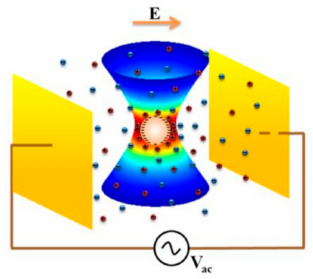
Figure 6. Schematic illustration of a charged colloidal particle held by an optical tweezer (with a harmonic potential) and driven by an oscillating electric field. The electric field direction is indicated at a particular instant of time. Adapted from